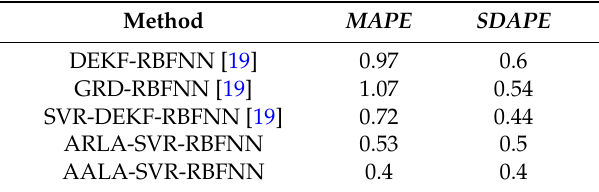
Figure 6. The forecasting results of the proposed AALA-SVR-RBFNN) in Case 2. Table 4. MAPE (%) and SDAPE (%) results for prediction methods in Case 2.